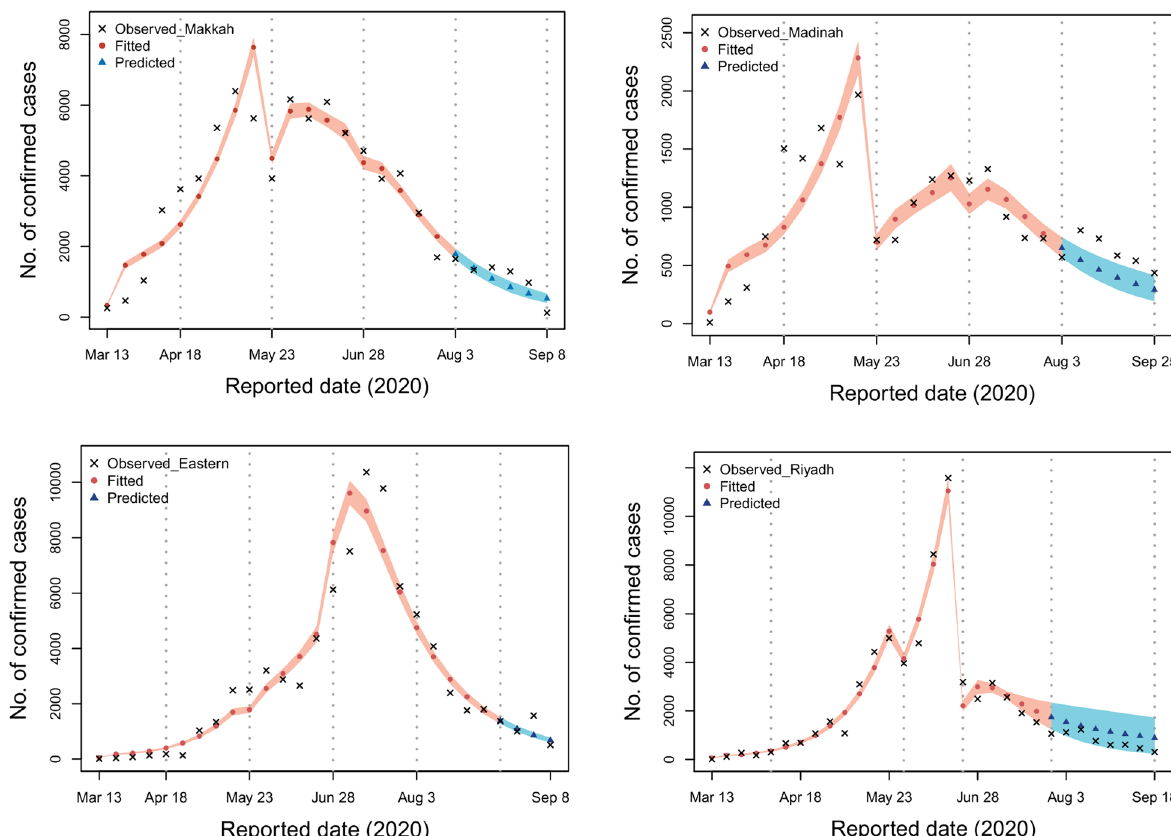
Figure 4. The relevant parameters were estimated for each of the four regions of interest by first fitting the data of each region, and then predicting using the parameters from period 4. This was done with each of the four regions of interest